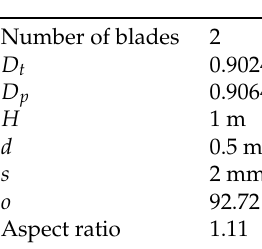
Figure 4. Schematic view of the wind turbine employed for validation. Table 2. Geometric parameters of the Savonius turbine used for